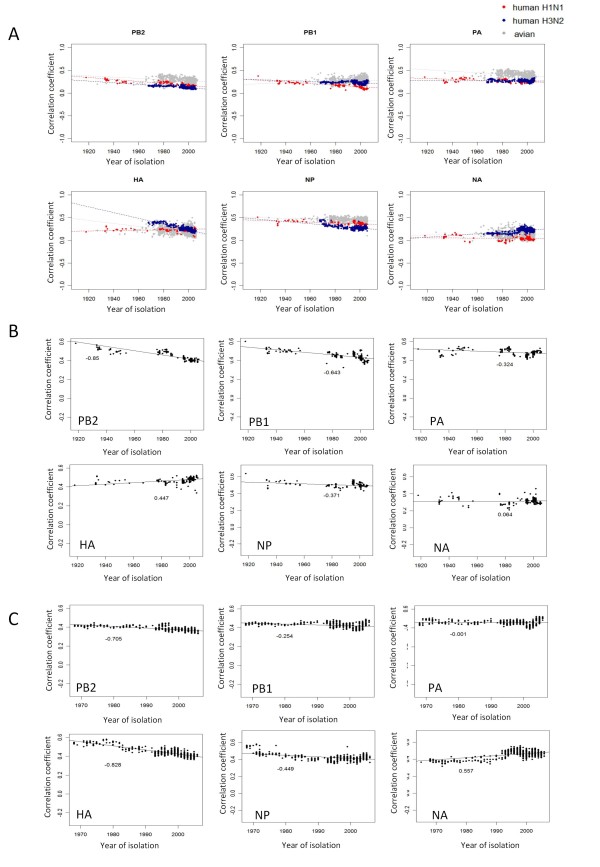
Trends in correlation between viral and human codon usage by year of viral isolation. (A) Correlation trend for human H1N1 and H3N2 subtypes and avian influenza. (B and C) Correlation of codon usage between H1N1 (B) or H3N2 (C) viral genes and genes expressed in human bronchial epithelial cells by year of virus isolation. The linear regression line and the correlation coefficient of each dataset are shown.